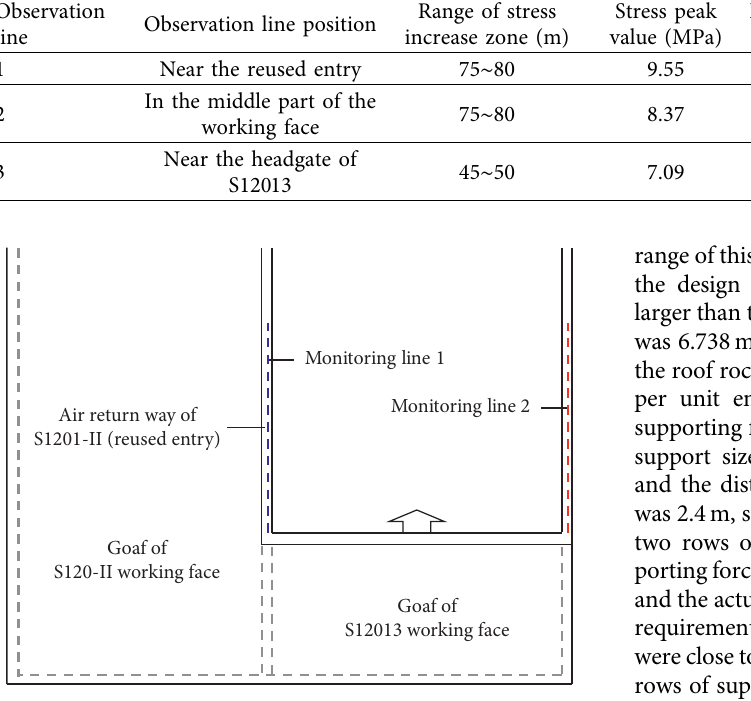
Figure 9: Monitoring position of roof deformation in the entry.